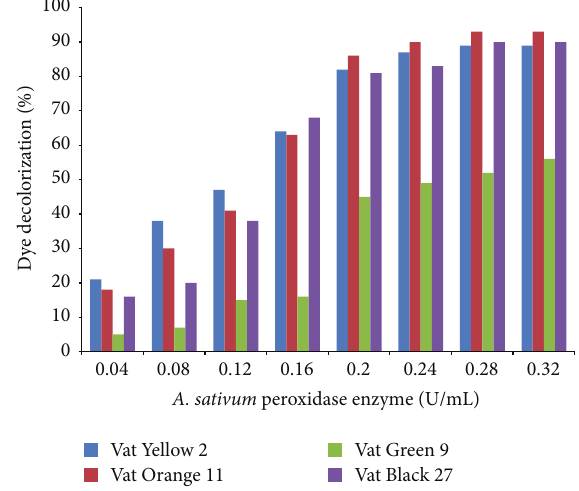
Figure 12: Effects of enzyme concentration on dye